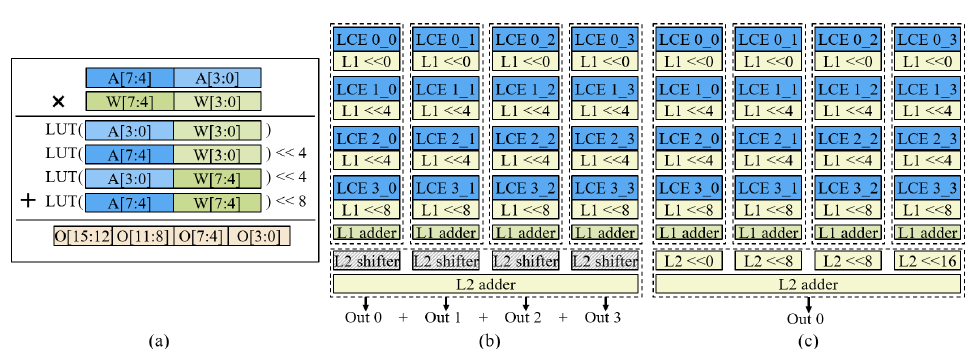
Figure 5. Precision scalable strategy. ( a ) Logic process for 8-bit multiplication using LUT. ( b ) Case for 8-bit multiplication, which outputs 4 data for SC array at a time. ( c ) Case for 16-bit multiplication, which outputs 1 data value for the SC array at a